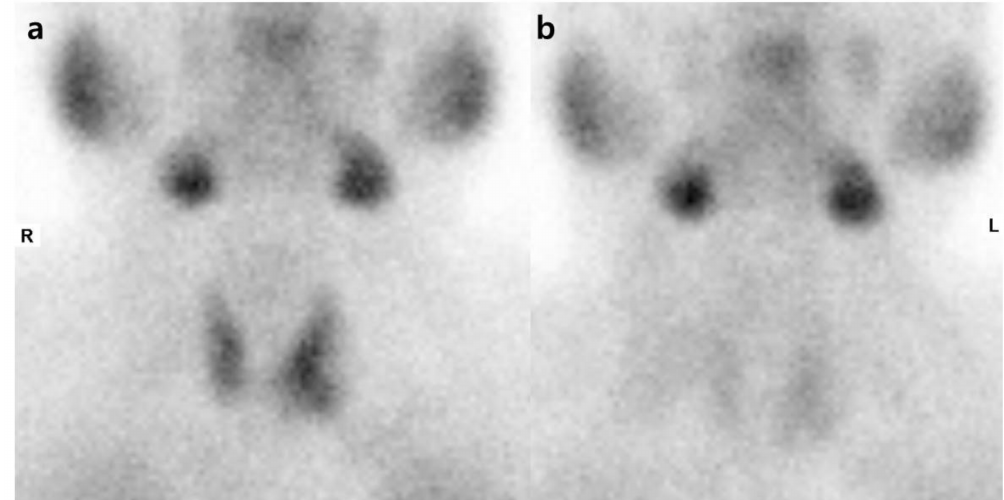
Figure 1. Dual-phase Tc-99m MIBI planar scintigraphy. The early images ( a ) show homogenous radioactive uptake in both lobes of the thyroid (enlarged left lobe) and the delayed images ( b ) show washout of radioactivity from the thyroid gland with no abnormal retention. R: right; L: left.